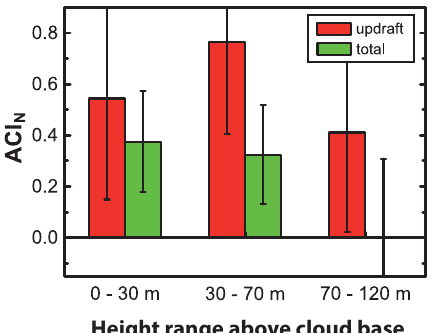
Height range above cloud base Figure 5. ACI N for updraft periods only (red, 13 cases) and when vertical wind information is not taken into account in the lidar data analysis and ACI retrieval (green, 26 cases). Error bars show the overall variability caused by atmospheric variability and retrieval